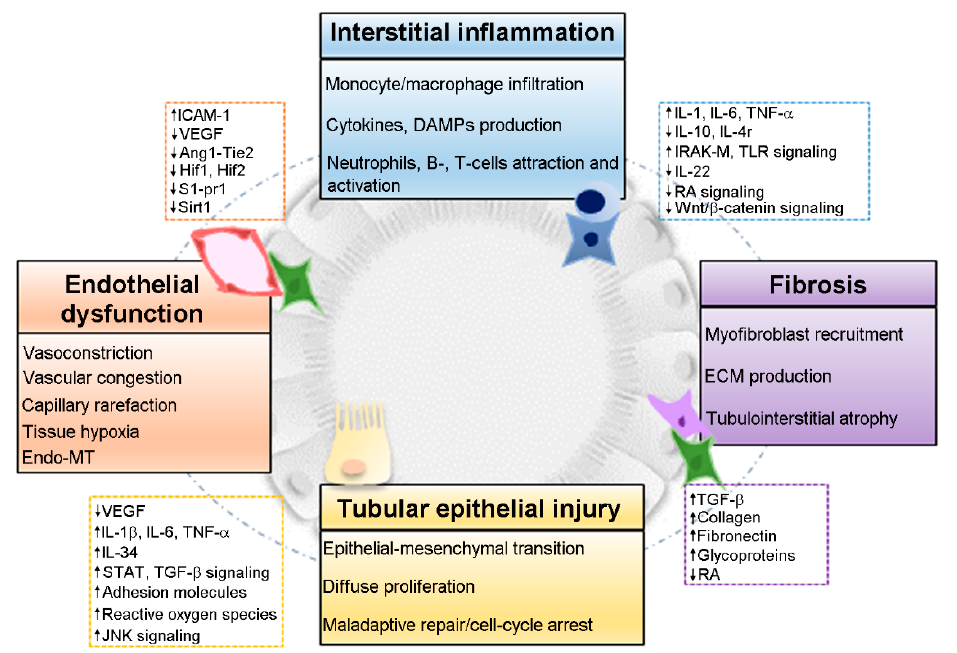
Figure 1. The interplay between endothelial dysfunction, interstitial inflammation, fibrosis and tubular epithelial injury concur to explain the acute kidney injury-to-chronic kidney disease (AKI-to-CKD) transition.